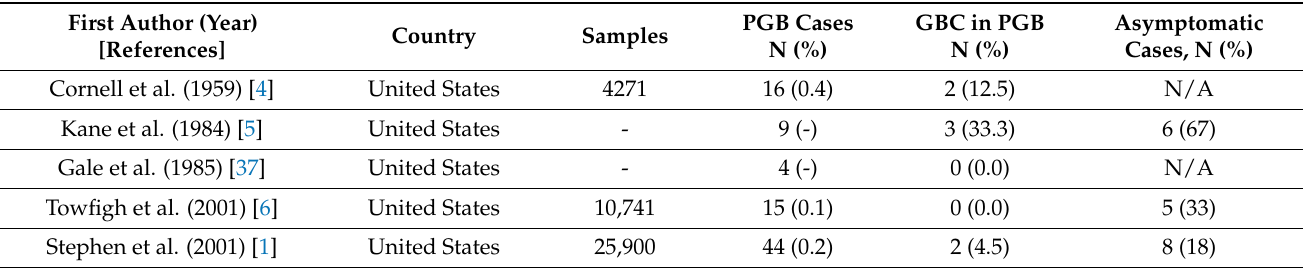
Table 1. Review of literature: cross-sectional studies evaluating the percentage of patients with porcelain gallbladder (PGB) who developed gallbladder cancer